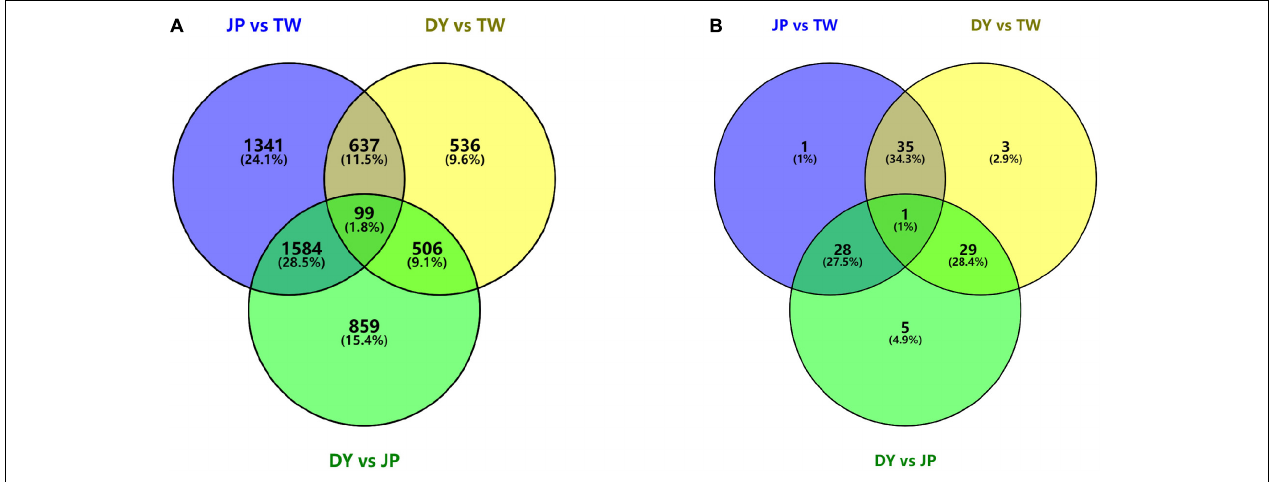
FIGURE 1 | Number of (A) differentially expressed genes and (B) differentially expressed miRNAs between the three H. diversicolor